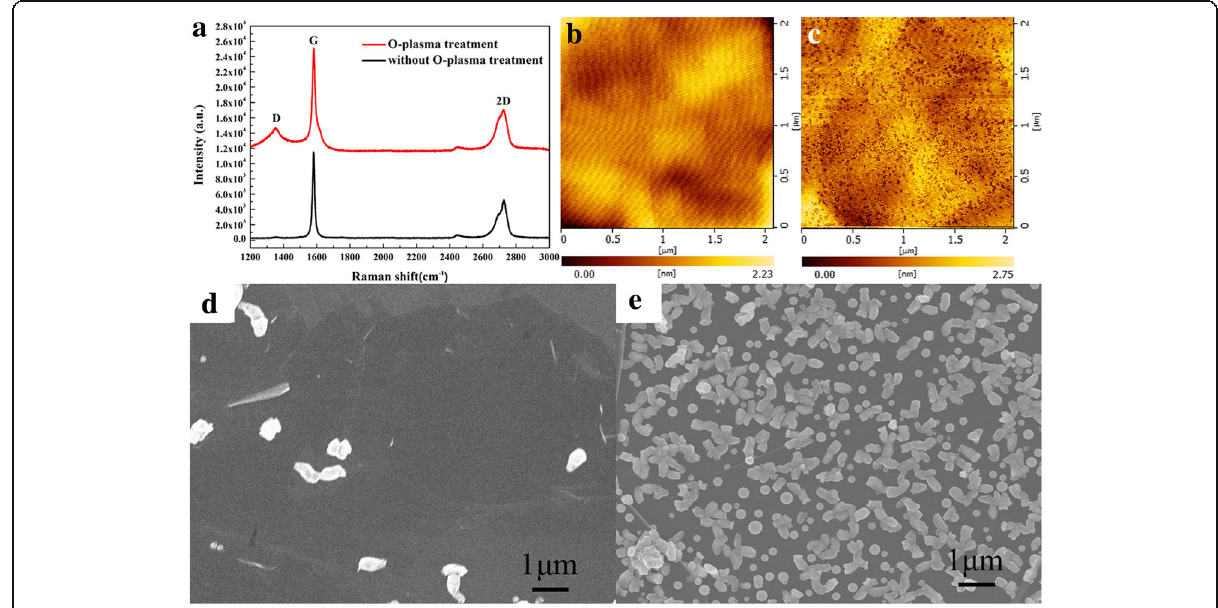
Fig. 1 a Raman spectra of the untreated graphite (black line) and treated graphite (red line). b , c 2×2 μ m 2 AFM images of the untreated graphite and treated graphite, respectively. d , e FE-SEM images of nucleation islands grown on untreated graphite and treated graphite,